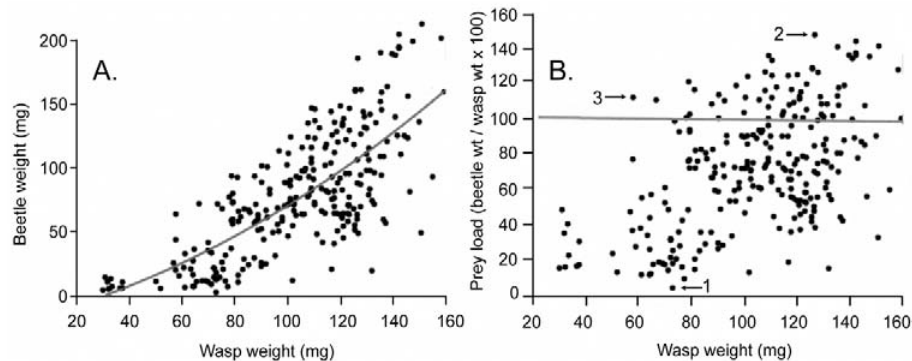
Figure 2. Relationship between predicted wasp weight and prey beetle weight in hunting Cerceris fumipennis . ( A ) Prey beetle weight as a function of wasp weight. The relationship is best described with the equation: Beetle wt. (mg) = –59.19378 + 1.3317934 * Wasp Wt. (mg) + 0.0037293 * (Wasp Wt. (mg) − 103.066) 2 ; R = 0.55, p < 0.0001. ( B ) Percent body weight (prey load) carried by C. fumipennis females ((beetle weight/wasp weight) × 100)). Points above the line indicate females carrying more than their own body weight. Data point 1: smallest prey load (4.8%, a wasp weighing 72.3 mg carrying a 3.5 mg Agrilus subrobustus ); data point 2: largest prey load (150.2%, a wasp weighing 125.8 mg carrying a 188.9 mg Buprestis rufipes) ; data point 3: smallest wasp carrying more than her own body weight (113.6% prey load, a wasp weighing 57.2 mg carrying a 65.0 mg Buprestis maculipennis ).